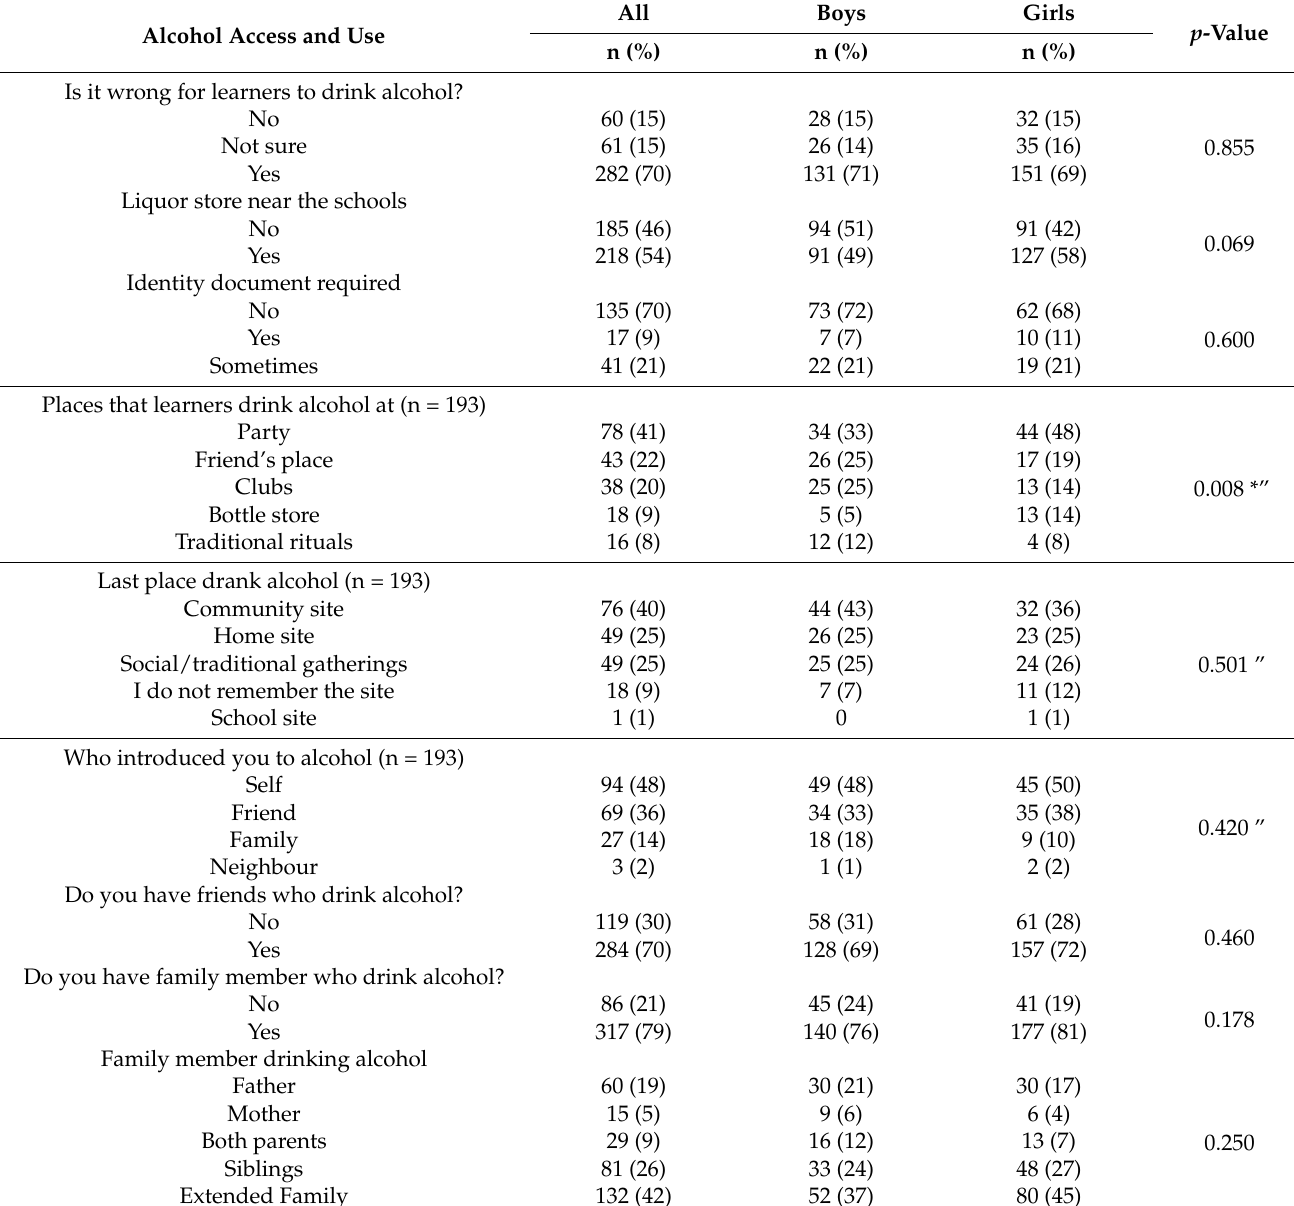
Table 2. Accessibility and motivations of alcohol use among school